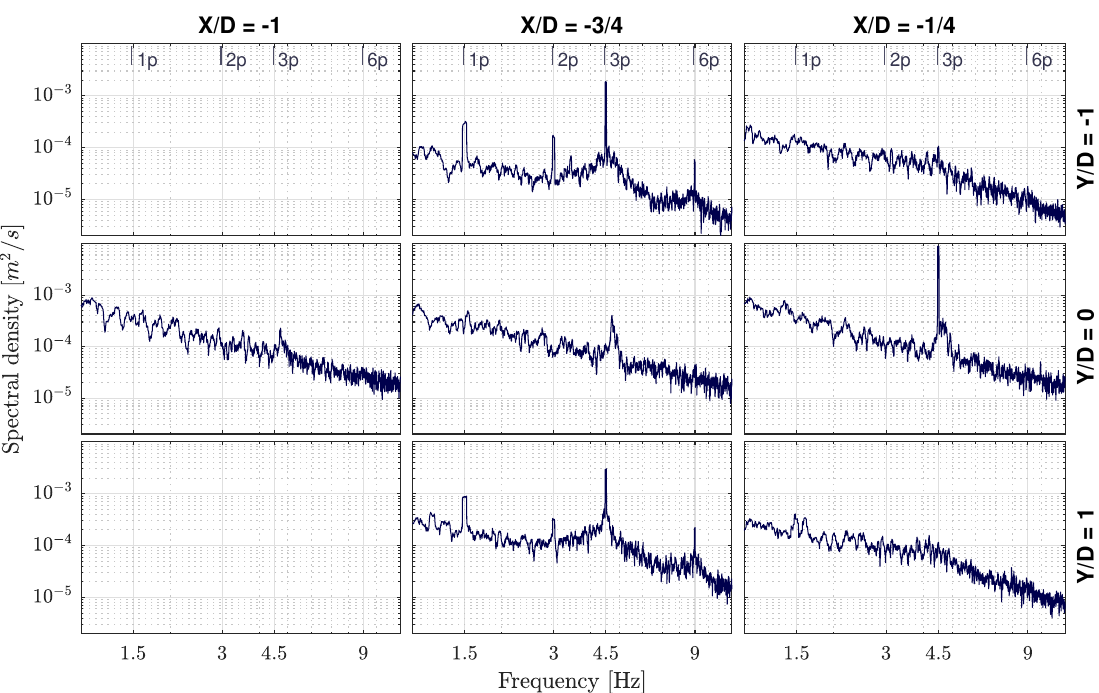
Figure 7. Example spectral density plots for streamwise velocity component U at seven positions for configuration AC3 with all three turbines operating at 90